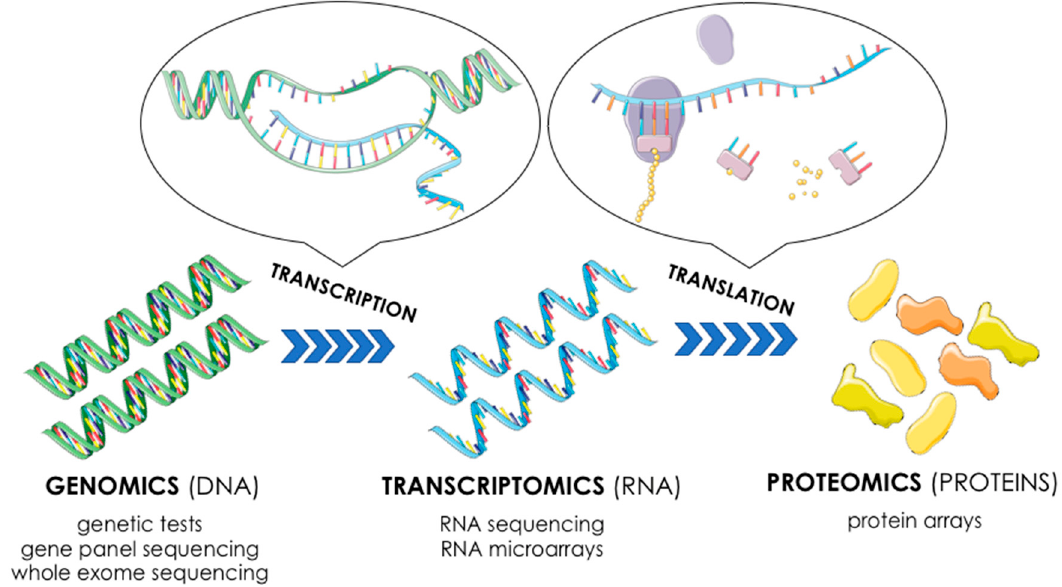
Figure 1. Omics—different approaches to gene expression (based on [22]). This figure was created using images from Servier Medical Art Commons Attribution 3.0 Unported License. (http://smart.servier.com). Servier Medical Art by Servier is licensed under a Creative Commons Attribution 3.0 Unported License.